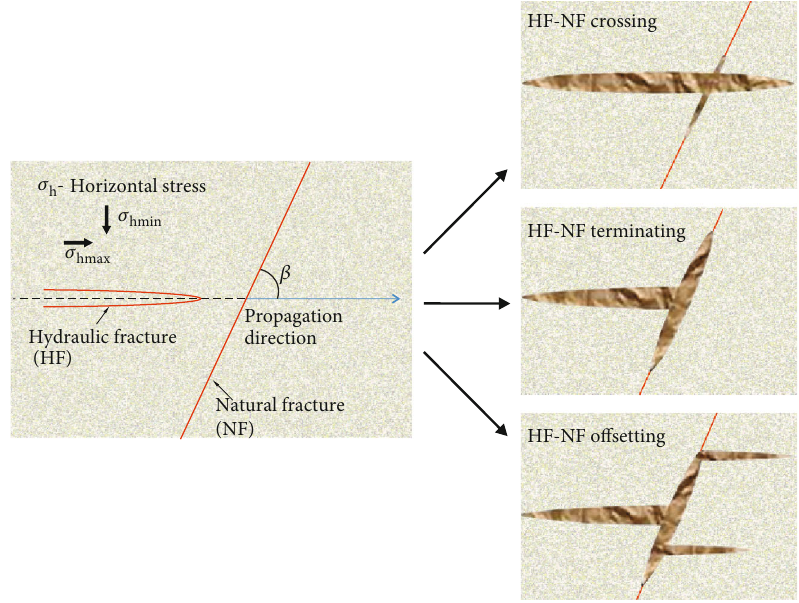
Figure 17: Schematic of a hydraulic fracture approaching a natural fracture and three possible scenarios upon the intersection of a hydraulic fracture with a natural fracture. Modi fi ed from Ref. [49]. Table 2: Modeling methods and evaluation of hydraulic fracturing in shale gas